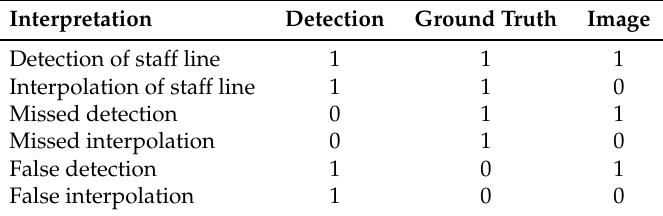
Table 2. Description of the staff line detection and tracking scheme performance score. At a certain pixel location, value ‘1’ indicates that: (a) Detection: a staff line detected reconstructed goes over such location; (b) Ground truth: a ground truth staff line goes over such location; (c) Image: a foreground pixel in the binary image is found at such